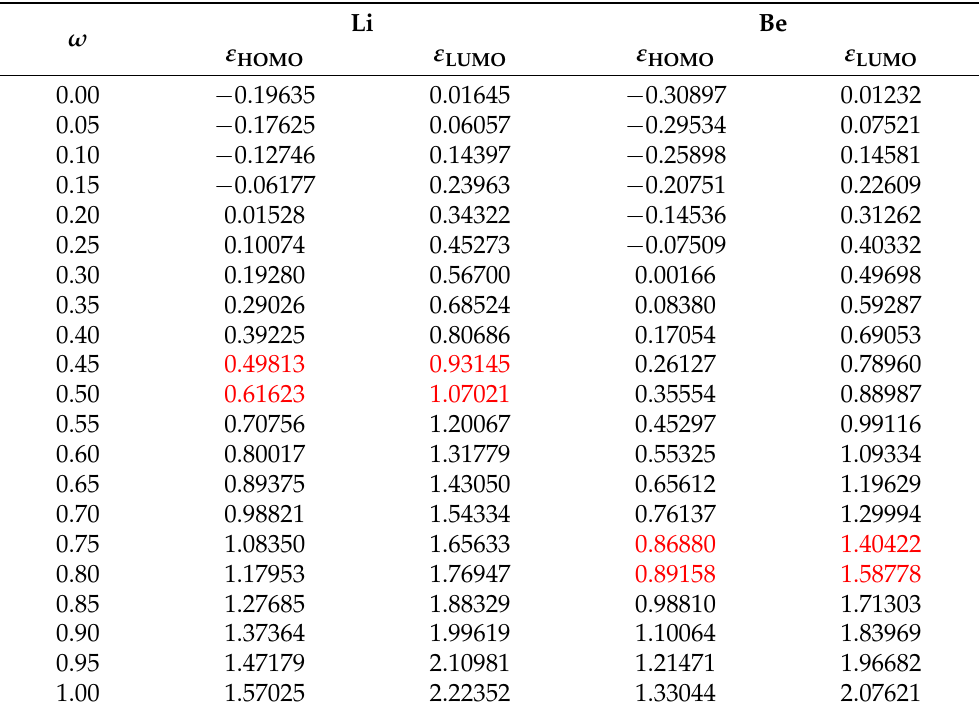
Table 1. HOMO and LUMO energies (in atomic units) of the confined Li and Be atoms. Values in red correspond to the region in which a configuration crossing occurred.